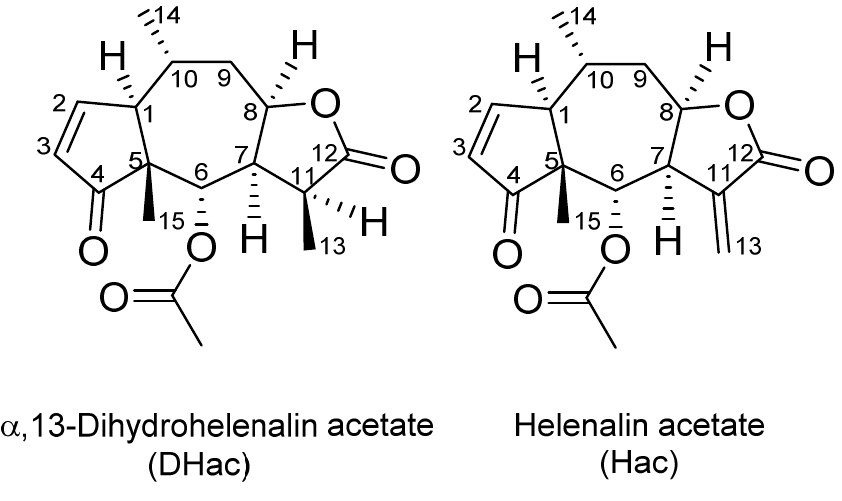
Figure 1. Chemical structures of the STLs under study.